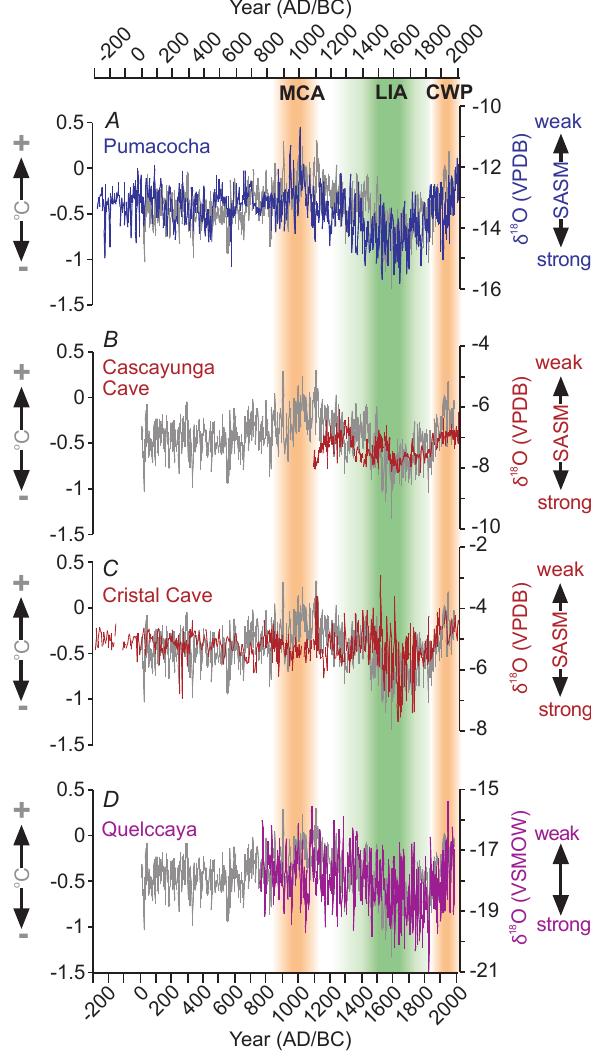
Fig. 3. (A) South American monsoon intensity changes over the past 2300yr as displayed in high-resolution stable isotopic records from (top to bottom) Pumacocha δ 18 O lake calcite; Cascayunga cave δ 18 O speleothem calcite, Cristal cave δ 18 O speleothem calcite and Quelccaya δ 18 O ice core. The Moberg et al. (2005) Northern Hemisphere temperature reconstruction is reproduced in each panel as a gray line for